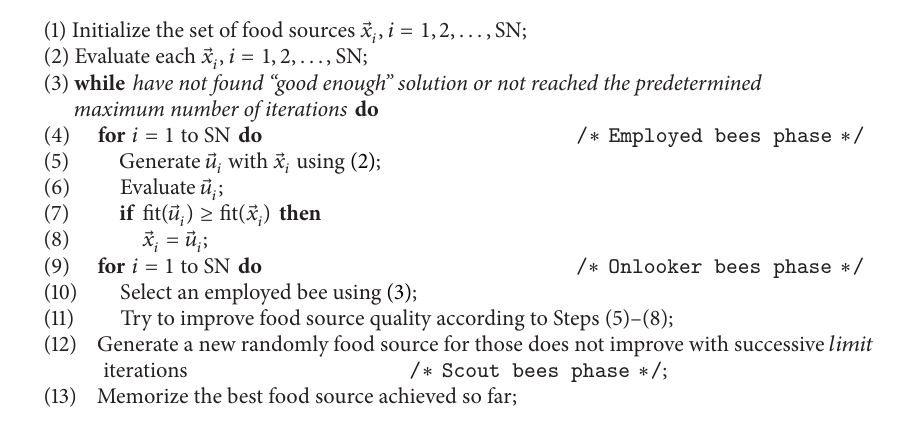
Algorithm 1: The pseudocode of artificial bee colony